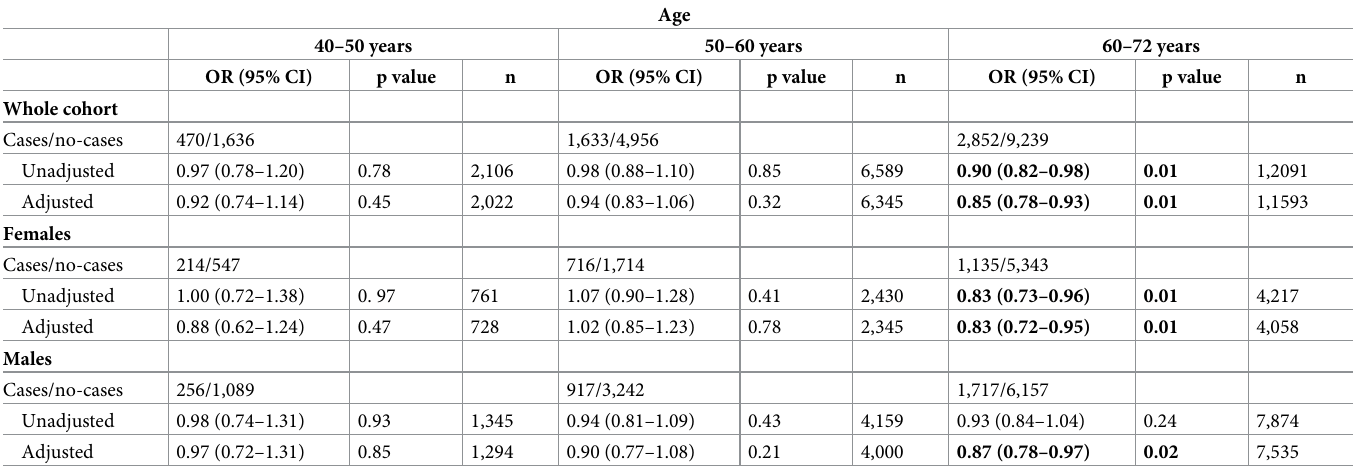
Table 4. Association between metformin and back pain considering age